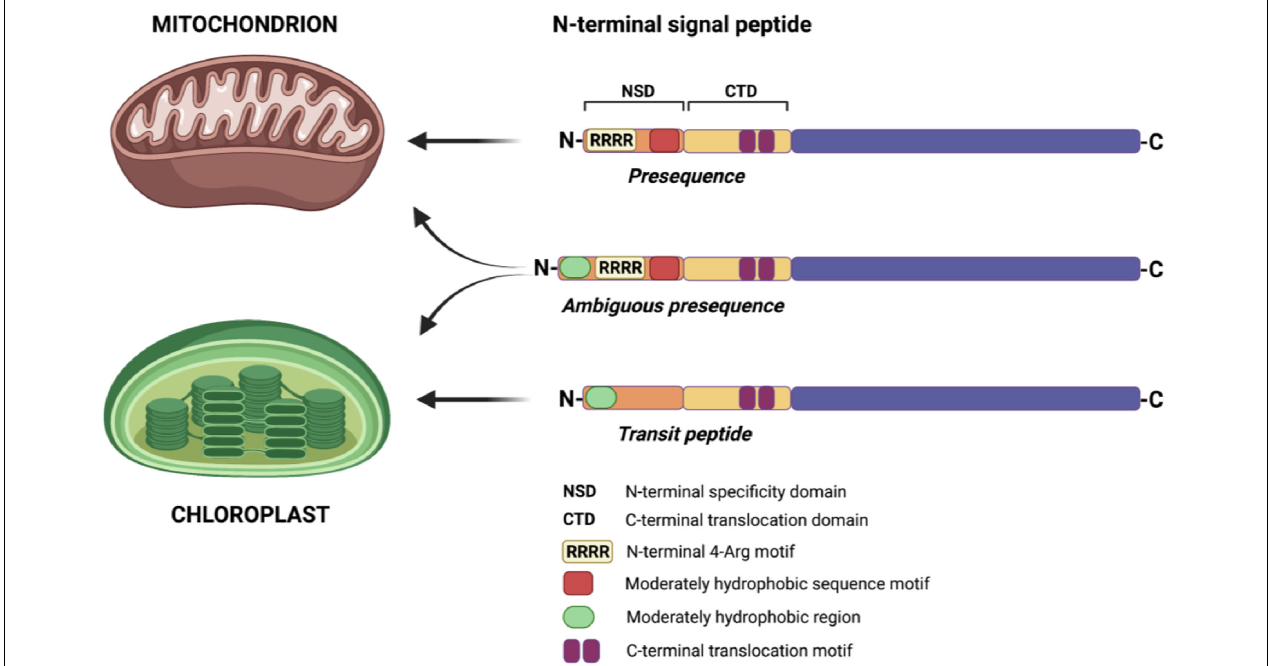
FIGURE 1 | Determinants of a targeting sequence for protein import to mitochondria and chloroplasts in plant cells. N-terminal signal peptides of both mitochondrial and chloroplast proteins contain the N-terminal specificity domain (NSD) and the C-terminal translocation domain (CTD). The NSD determines the specificity of protein targeting, while the CTD of both targeting sequences is interchangeable. In mitochondrial presequences, the N-terminal 4-Arg motif and moderately hydrophobic sequence motif are crucial for protein-specific import into mitochondria. In chloroplast transit peptides, the presence of a moderately hydrophobic region in the NSD is sufficient to target a protein into chloroplasts. In the case of dual-targeted sequences (ambiguous presequences), combining the N-terminal region of transit peptide with mitochondrial presequence results in a protein import to both mitochondria and chloroplasts. Based on Lee et al. (2019) and McKinnon and Theg (2019). Created with